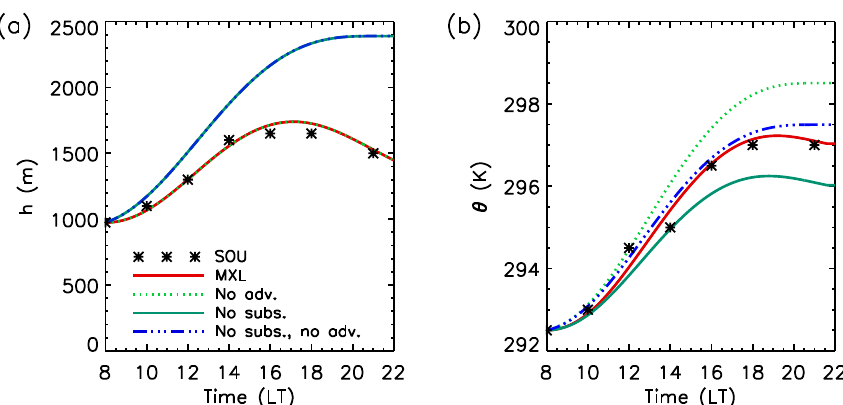
Fig. 16. Different evolutions of (a) the ABL height and (b) the potential temperature predicted by the MXL model. Subsidence and advection are separately enabled and disabled for the different numerical experiments, resulting in four cases. The results are compared to radiosonde observations, SOU. The most accurate case, with advection and subsidence enabled, is labelled MXL. Note that the advection does not significantly affect the boundary layer height evolution. Therefore, the curves are superposed in (a) for the cases with and without prescribed advection.